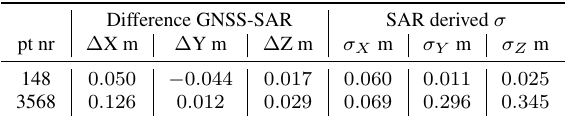
Table 2. Difference between GNSS positions and geodetic SAR positions of two validation points including the SAR derived